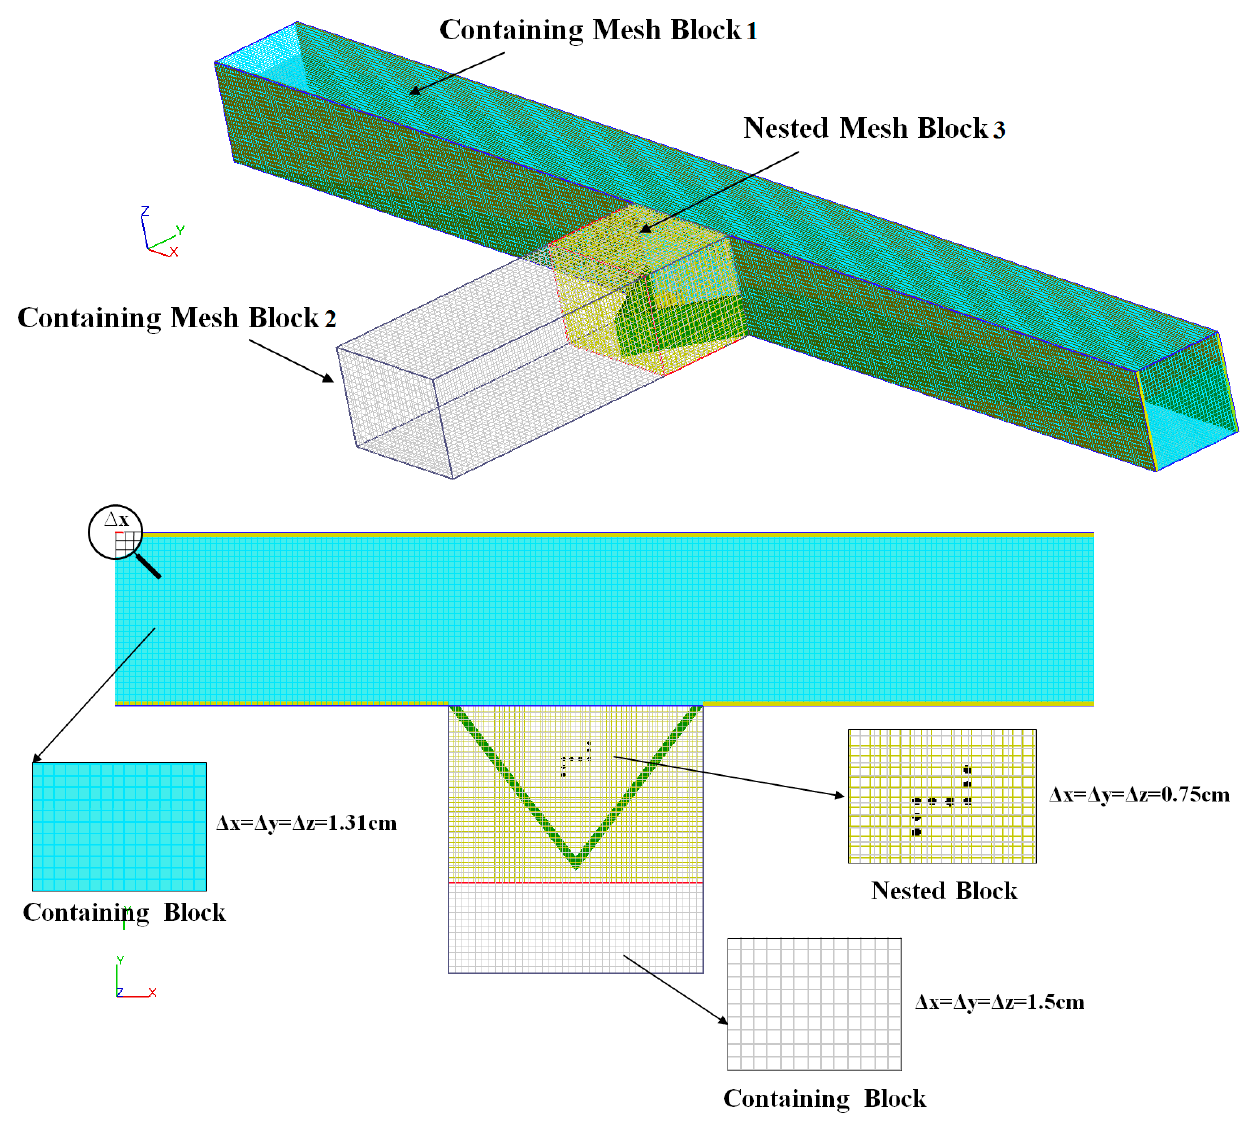
Figure 4. Gridding for FLOW-3D simulations.